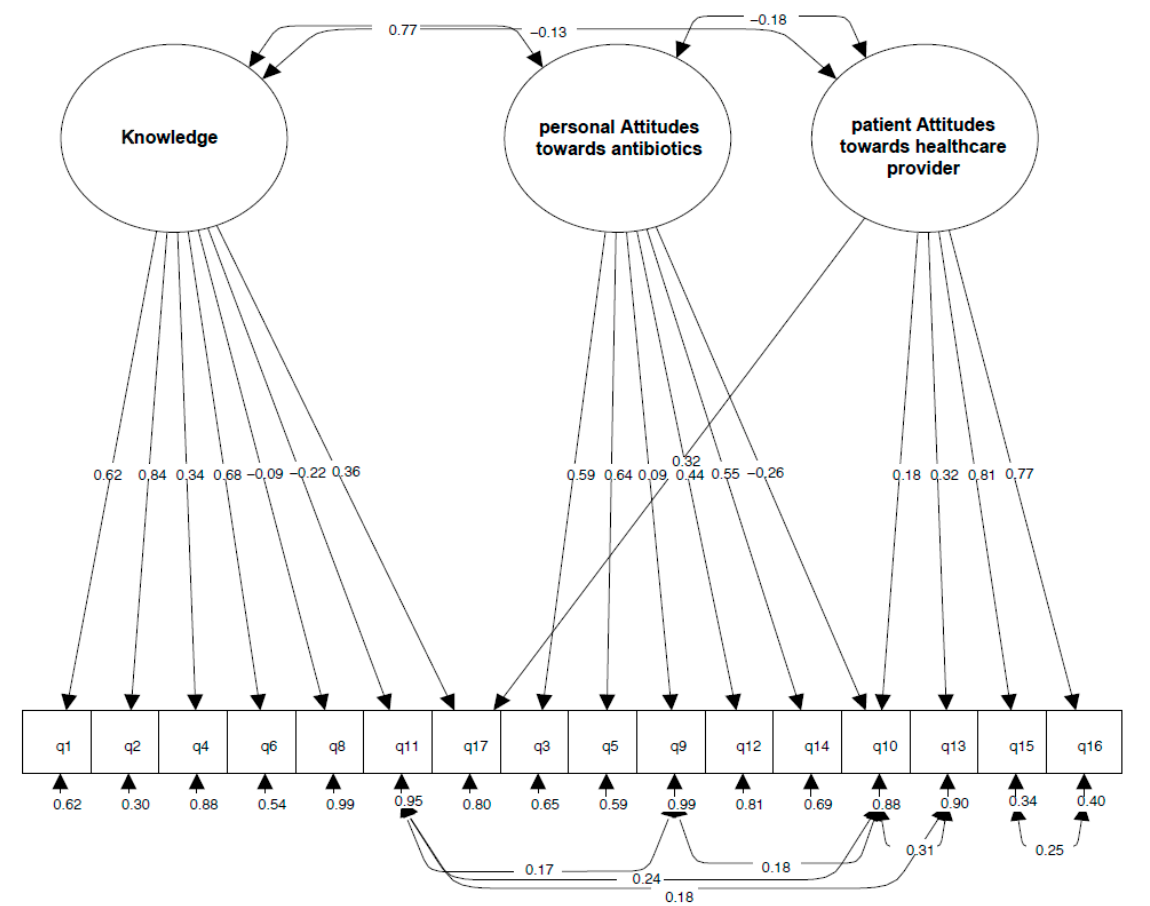
Figure 1. Representation of the knowledge and attitudes model selected by CFA analysis (Model 4). The Figure represents each of the three factors ( knowledge, personal attitudes towards antibiotics and patient attitudes towards healthcare provider ) with its respective standardized item loadings and item residuals. Double-sided arrows represent correlations between the variables. Single headed arrows represent the correlation of each item with its corresponding factor(s).